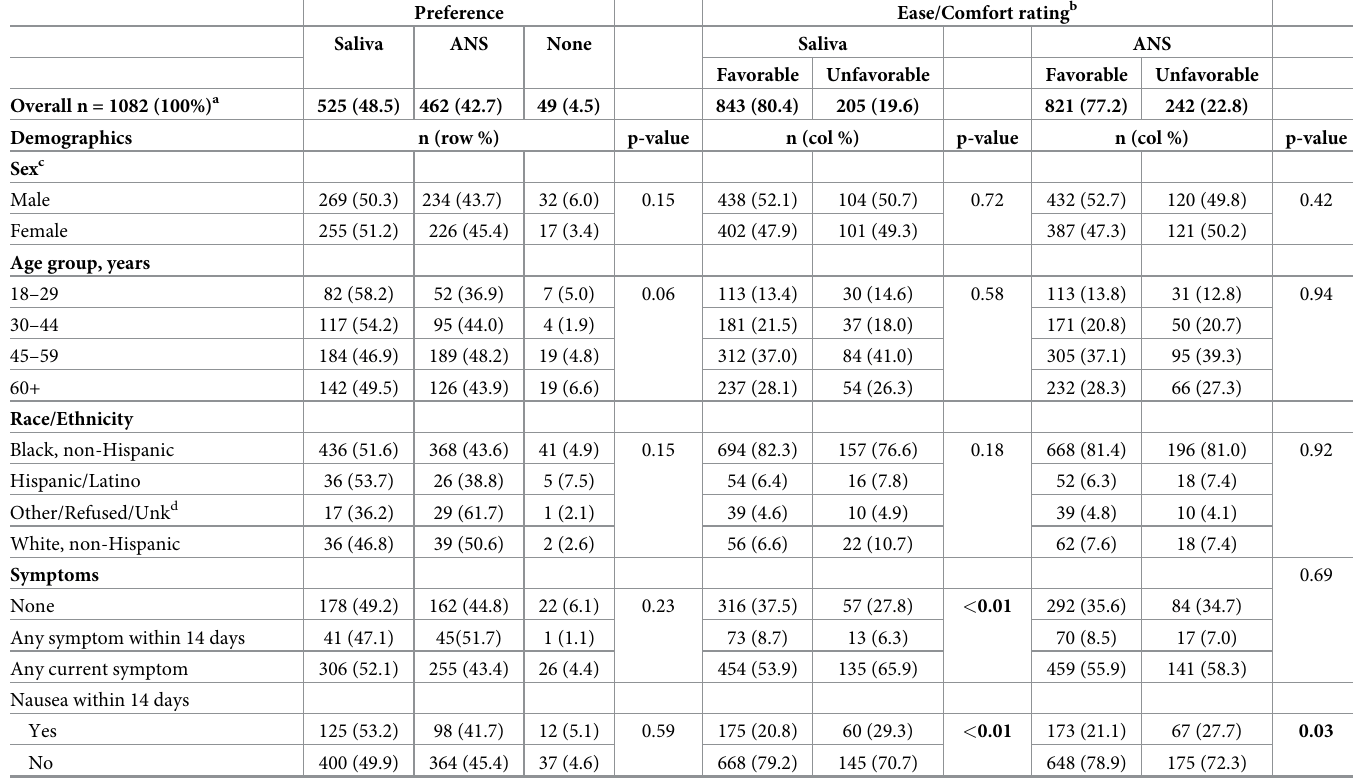
Table 2. Participant preference and favorability rating � for self-collected saliva and anterior nasal swabs by location, reported demographics, symptoms and under- lying medical history, Grady Memorial Hospital, Atlanta, GA, August–October